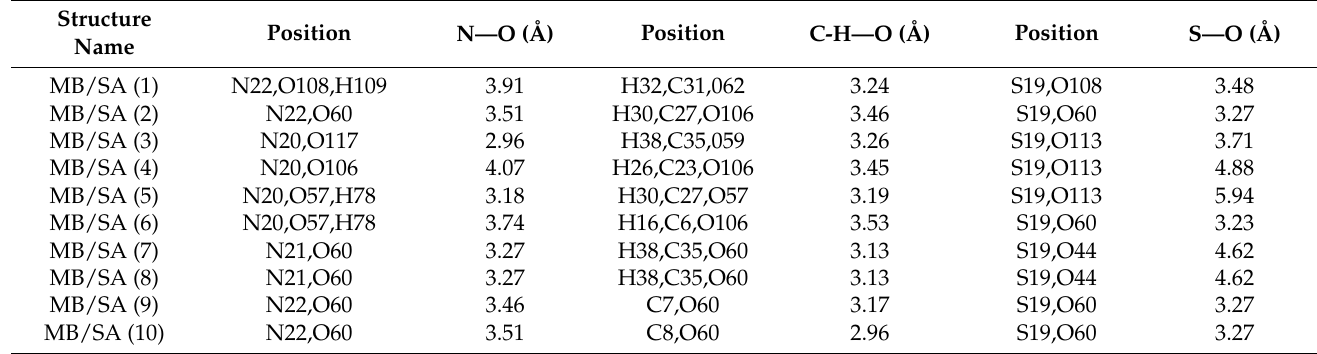
Table 2. The atomic distances between N, C, and S from MB and O from SA for the complexes obtained at the B3LYP/6- 31G(d) level.